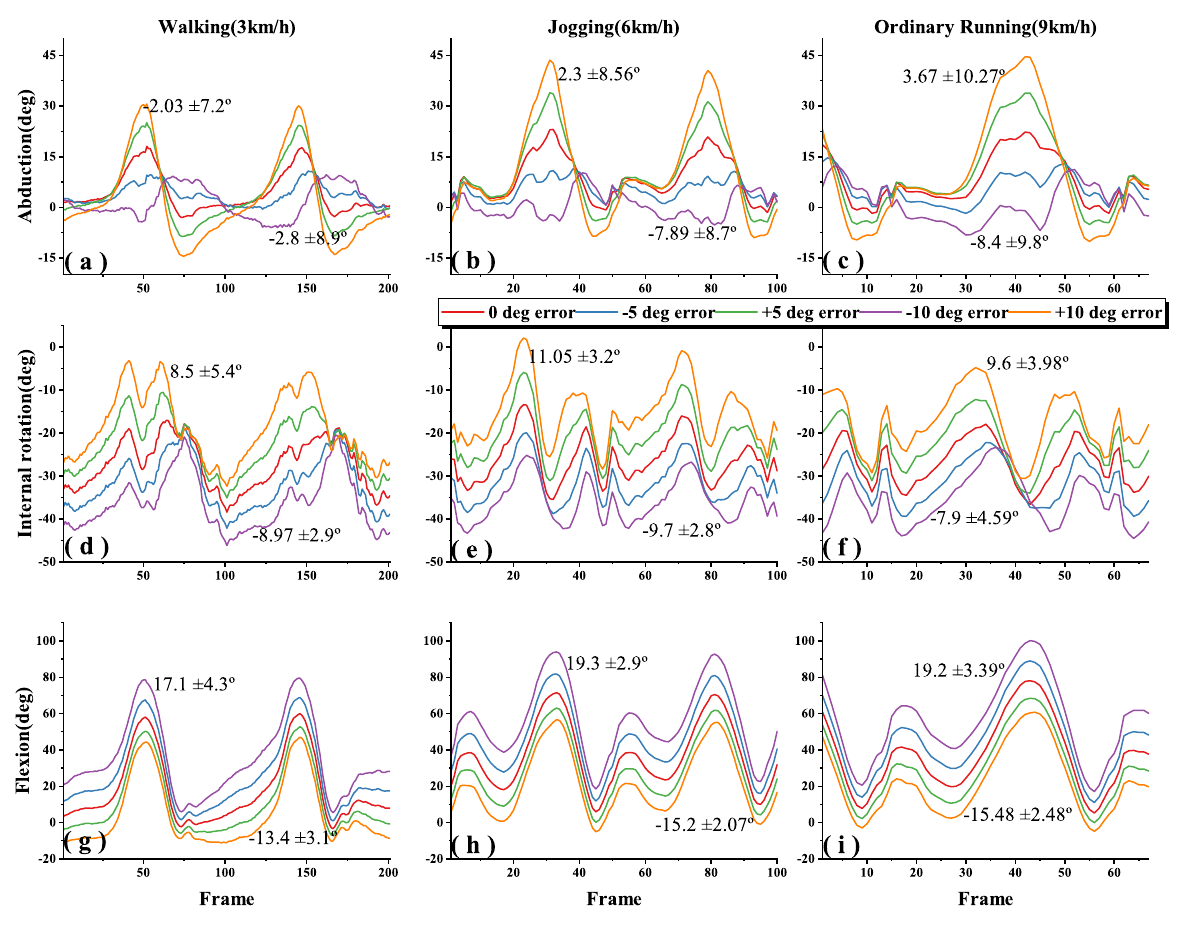
Figure 6. Effects of IMU to shank misalignment error on 3-DOF knee angle estimation during different motions; ( a – c ), ( d – f ), ( g – i ) indicate the abduction, internal rotation and flexion angle of the knee during walking (3 km/h), jogging (6 km/h) and ordinary running (9 km/h), when added IMU to shank misalignment error from − 10 ◦ to +10 ◦ in steps of 5 ◦ . Table 1. This table shows the maximum, minimum and range of motion (ROM) values of the estimated 3-DOF knee angle during walking, jogging and ordinary running for all